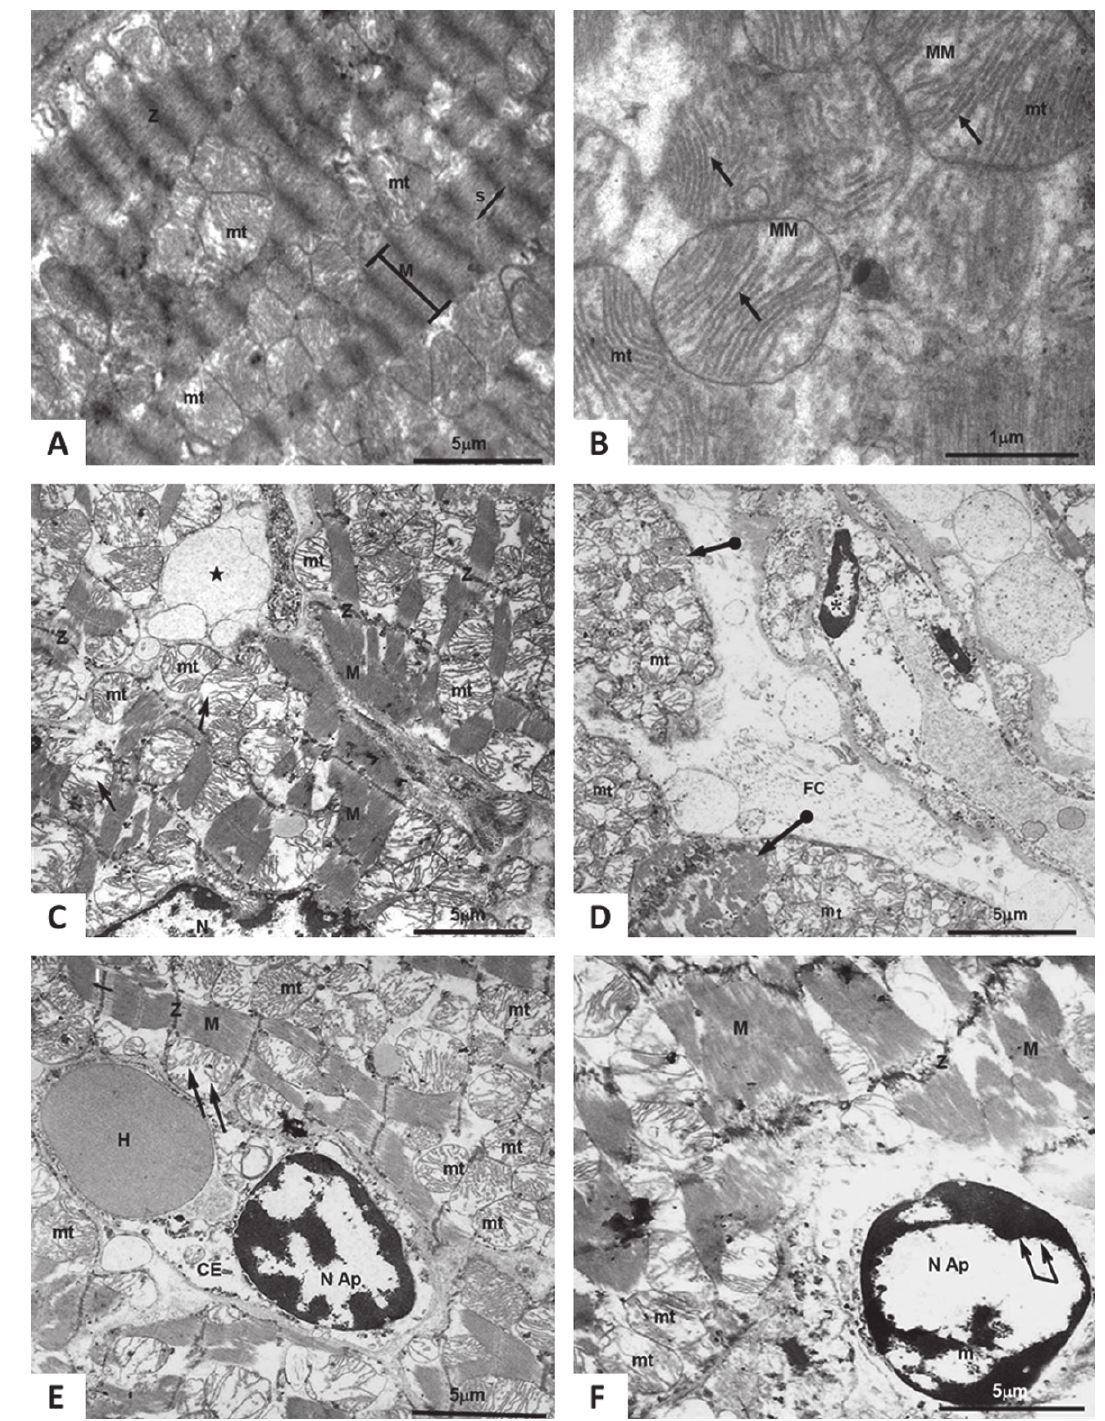
Fig. 3 - Transmission electron microscopy. (A) and (B) Control group; (C) , (D) , (E) and (F) Irradiated group. mt: mitochondria, s: sarcomeres, one arrow: cristae, MM: mitochondrial matrix, M: myofibrils, asterisk: vacuoles containing cytoplasmic material, N: nucleus, arrow with end ball: cardiac muscle fibers, FC: collagen fibers, H: erythrocytes, Nap: apoptotic nuclei, CE: endothelial cell, double arrow: highly condensed